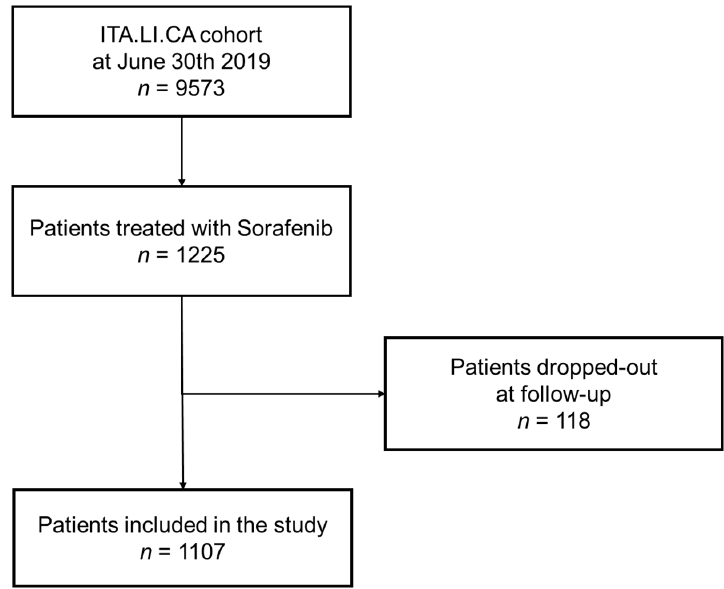
Figure 1. Flow-chart of the selection of ITA.LI.CA patients included in the study.